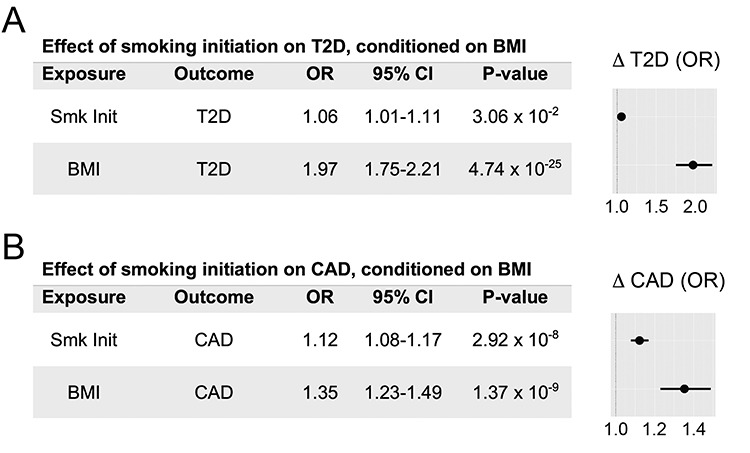
BMI largely mediates the effect of smoking initiation on increased type 2 diabetes (T2D) risk, but not CAD risk. Instrumental variables for these experiments comprised ~286 SNPs from smoking initiation GWAS summary statistics (18). (A) Multivariable Mendelian randomization results show that genetically determined BMI largely confounds the effect of smoking initiation on T2D risk. (B) Multivariable MVMR results show that smoking initiation retains a strong independent effect on CAD risk after conditioning on BMI. OR estimates, 95% confidence intervals and forest plots represent changes in outcomes associated with 2-fold increase in genetic smoking initiation ‘risk’, conditioned on BMI.